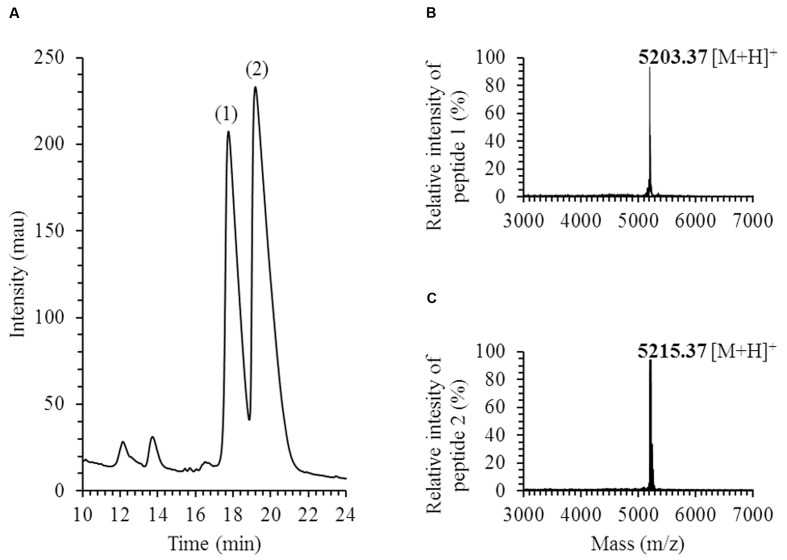
Purification and identification of enterocins produced by Enterococcus faecium LCW 44.
(A) HPLC elution profile (chromatogram) at 214 nm; (B) MALDI-TOF MS spectrum of enterocin L50B (peptide 1); (C) MALDI-TOF MS spectrum of enterocin L50A (peptide 2); mass is mono-isotopic, in Daltons.